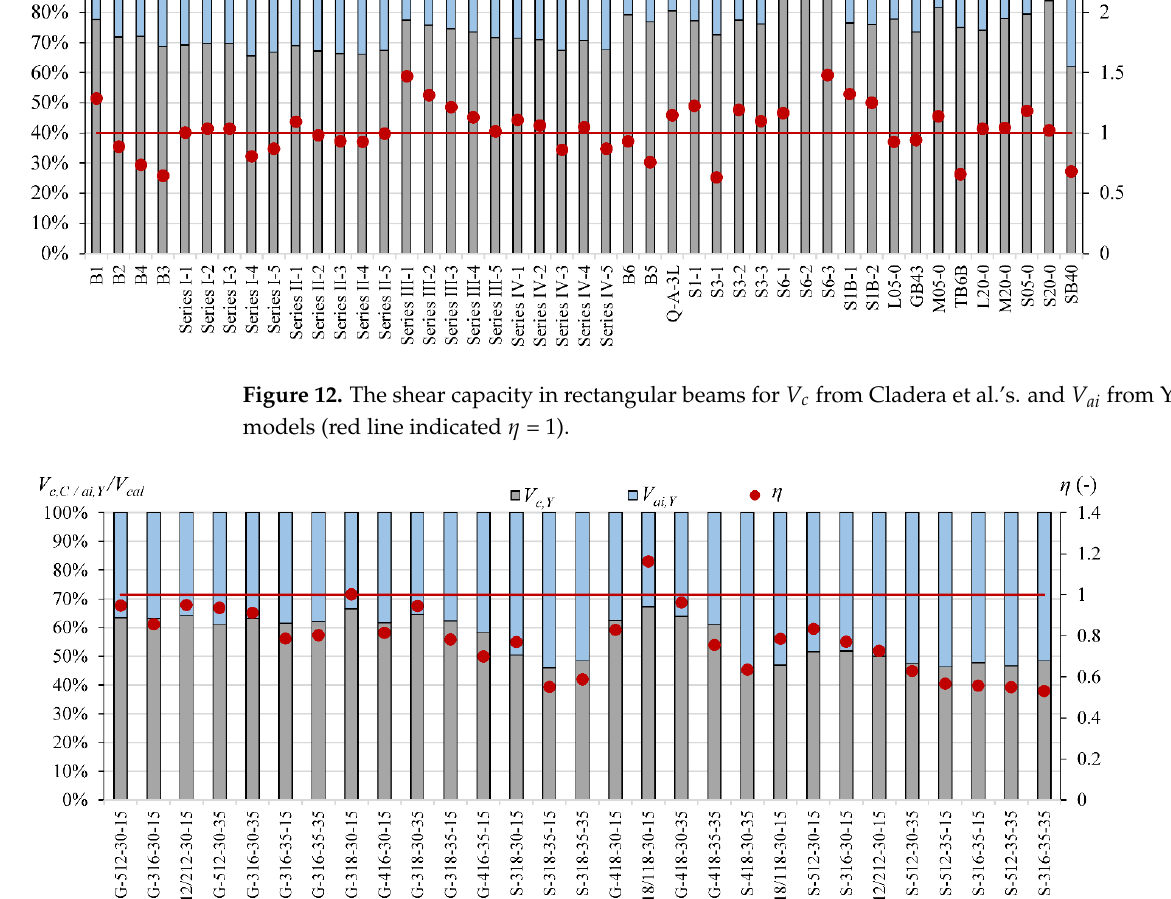
Figure 12. The shear capacity in rectangular beams for V c from Cladera et al. ’s. and V ai from Yang’s models (red line indicated η = 1).